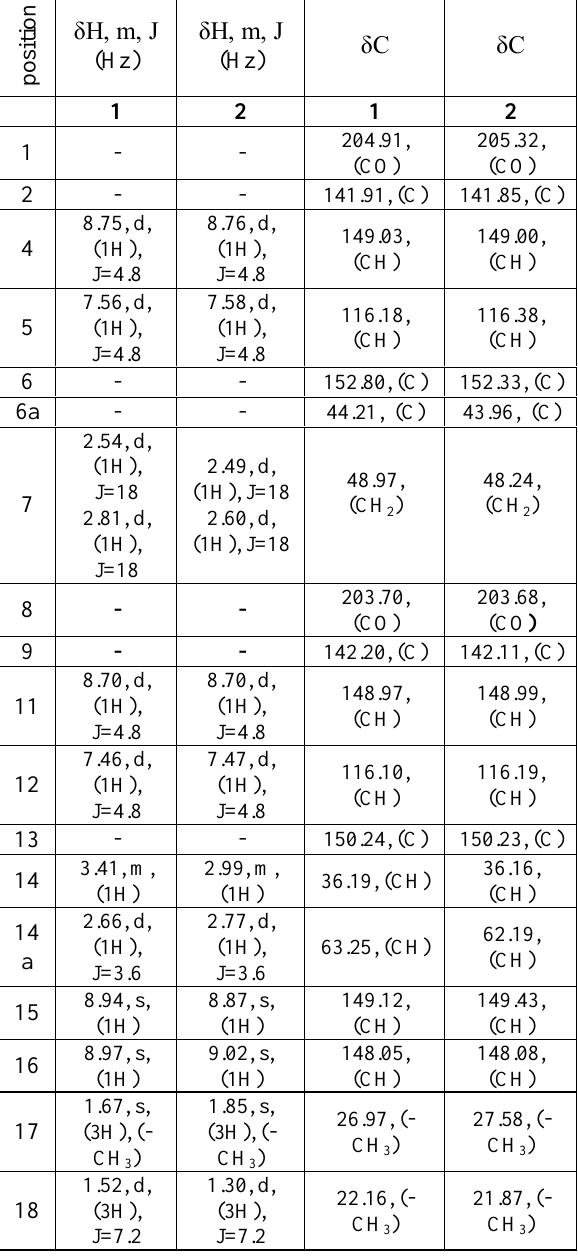
Table 1. 1 H and 13 C NMR data for compounds 1 and 2 in CDCl , (δ in ppm, J in 3